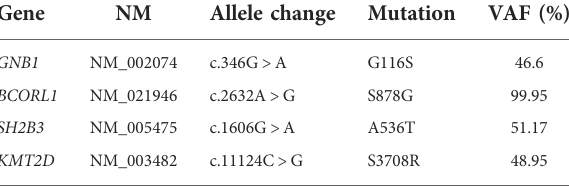
TABLE 1 The mutations of pediatric AML in this